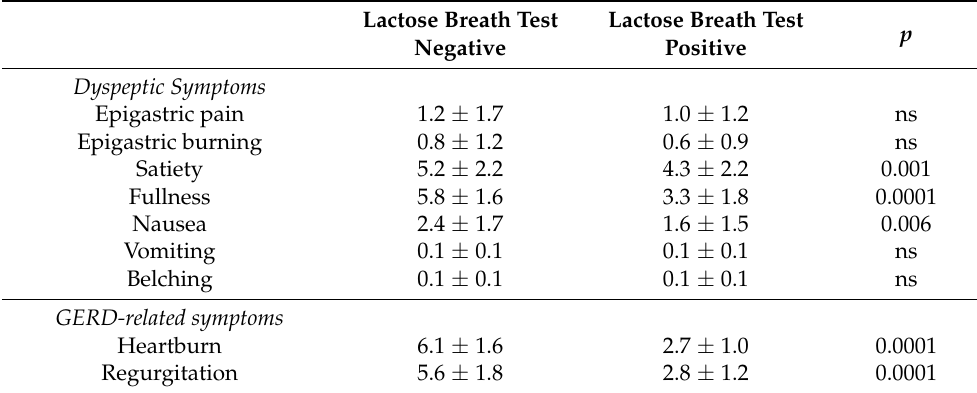
Table 2. Severity of dyspeptic and GERD-related symptoms in patients with and without lactose malabsorption.